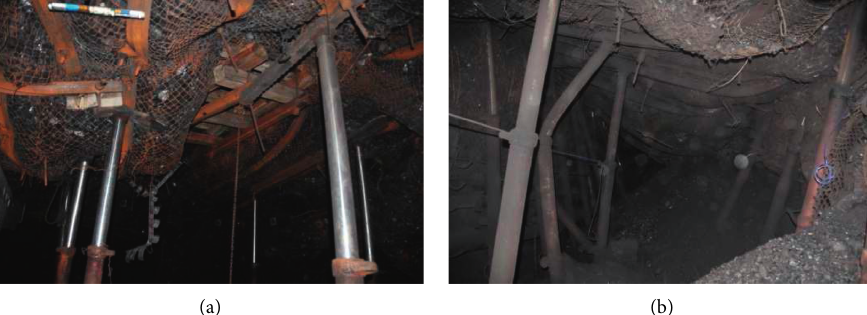
Figure 3: The figures of roadway impact instability in the 1305 working face. (a) Roof caving. (b) Roadway deformation.